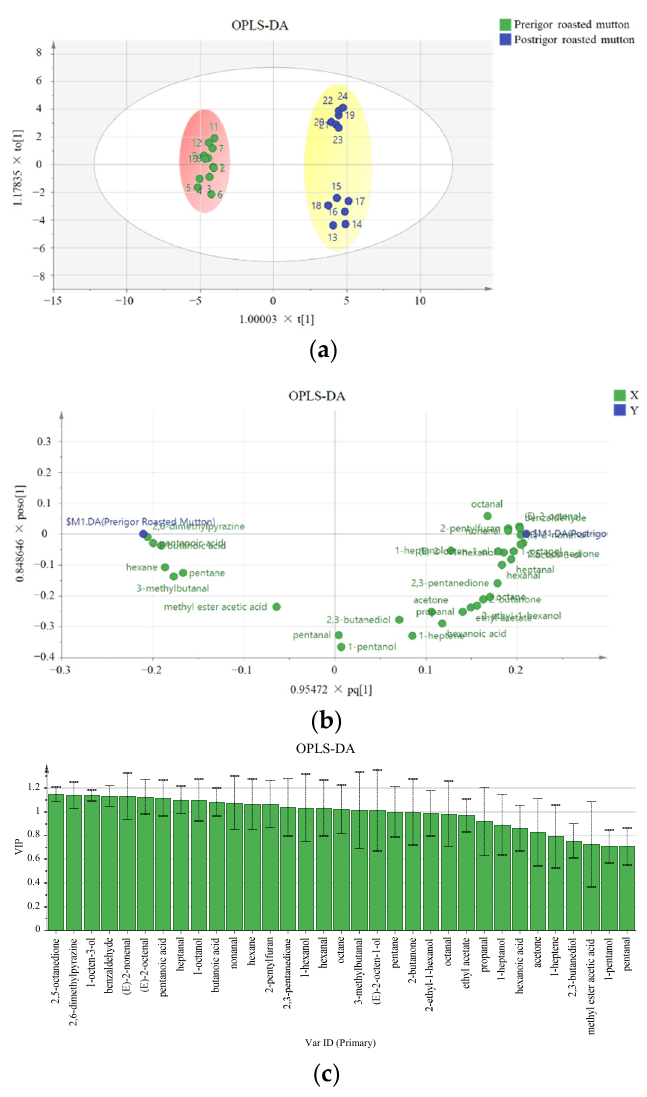
Figure 2. OPLS-DA of aroma compounds in the pre- and postrigor roasted mutton. ( a ) score scatter plot. ( b ) loading scatter plot. ( c ) VIP plot.